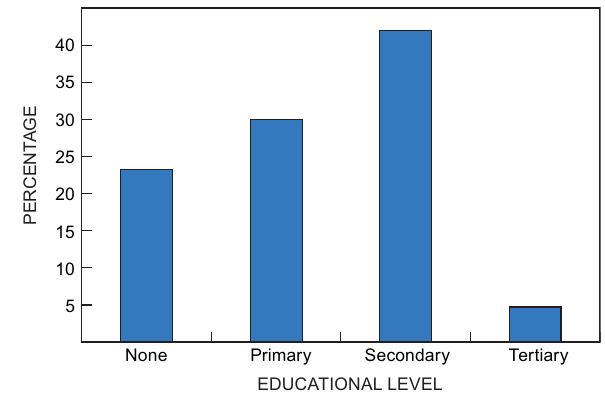
Figure 1: Gender distribution.